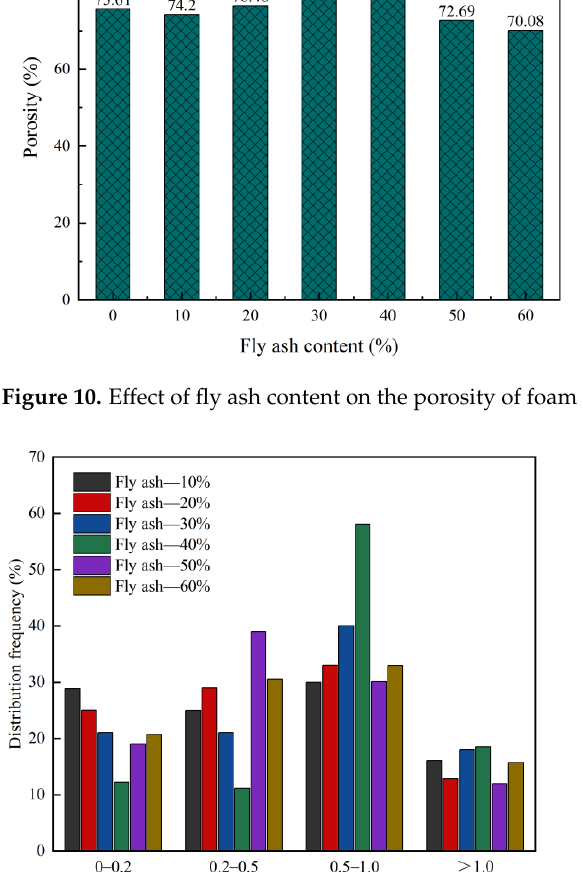
Figure 11. Effect of fly ash content on pore size distribution frequency of foam concrete.